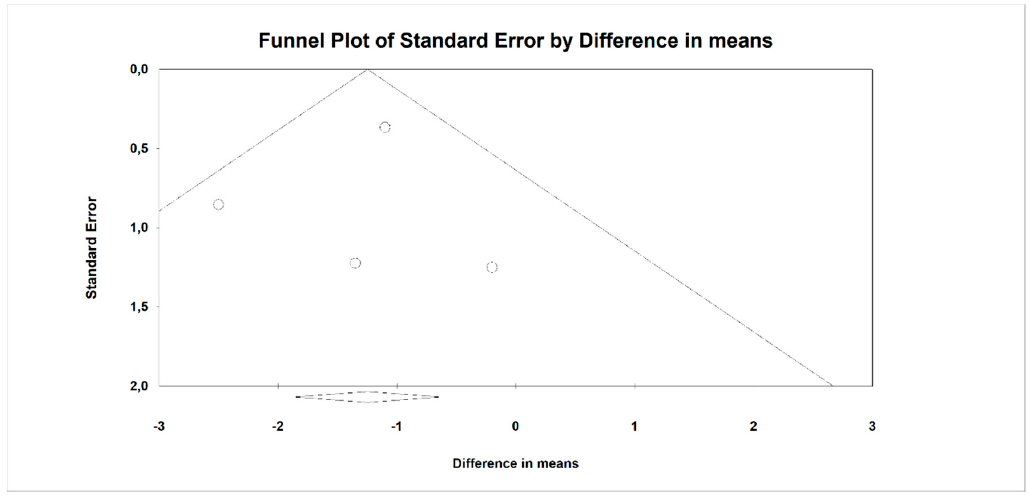
Figure 5. Funnel plot for endpoint BMI (difference in means) in the present meta-analysis. Egger’s test: p = 0.827.